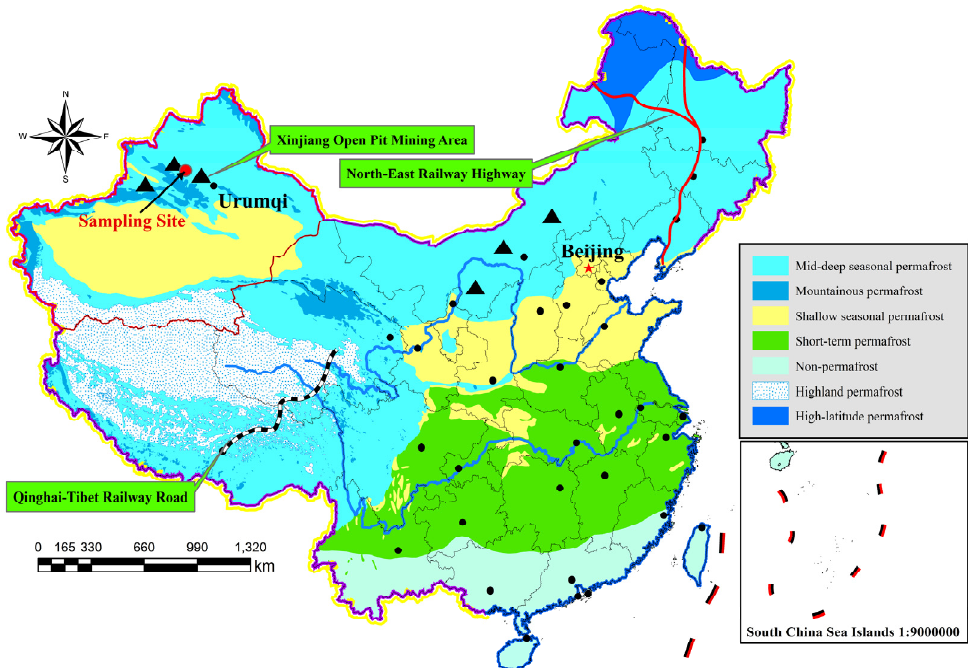
Figure 1. Distribution of cold regions in China and sampling points for the red sandstone sample; the red circles refer to the approximate locations of the sandstone sampling.